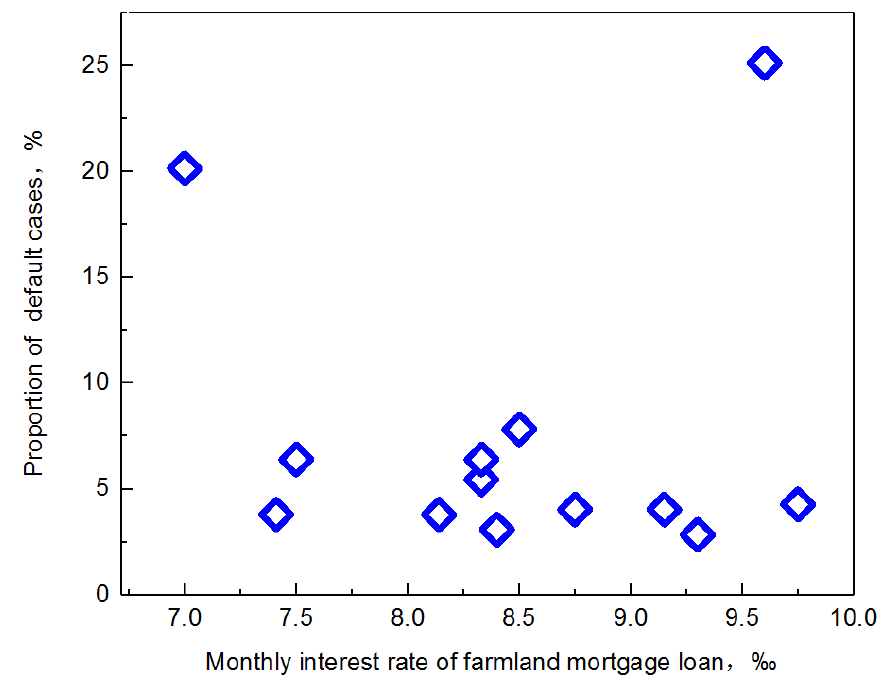
Figure 5. Farmland mortgage monthly interest rate.